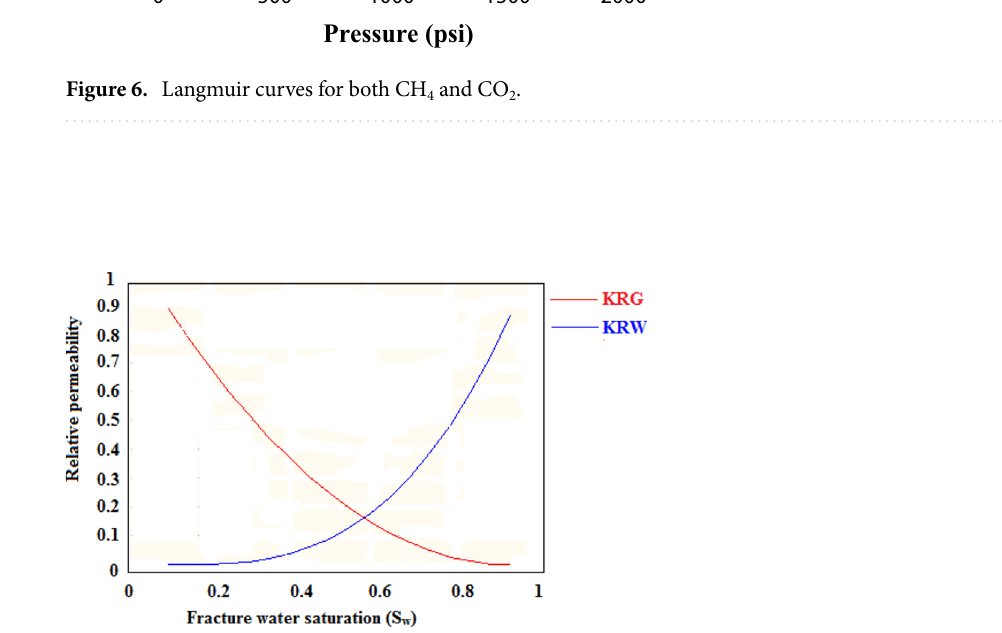
Figure 7. Relative permeability curve for the gas and